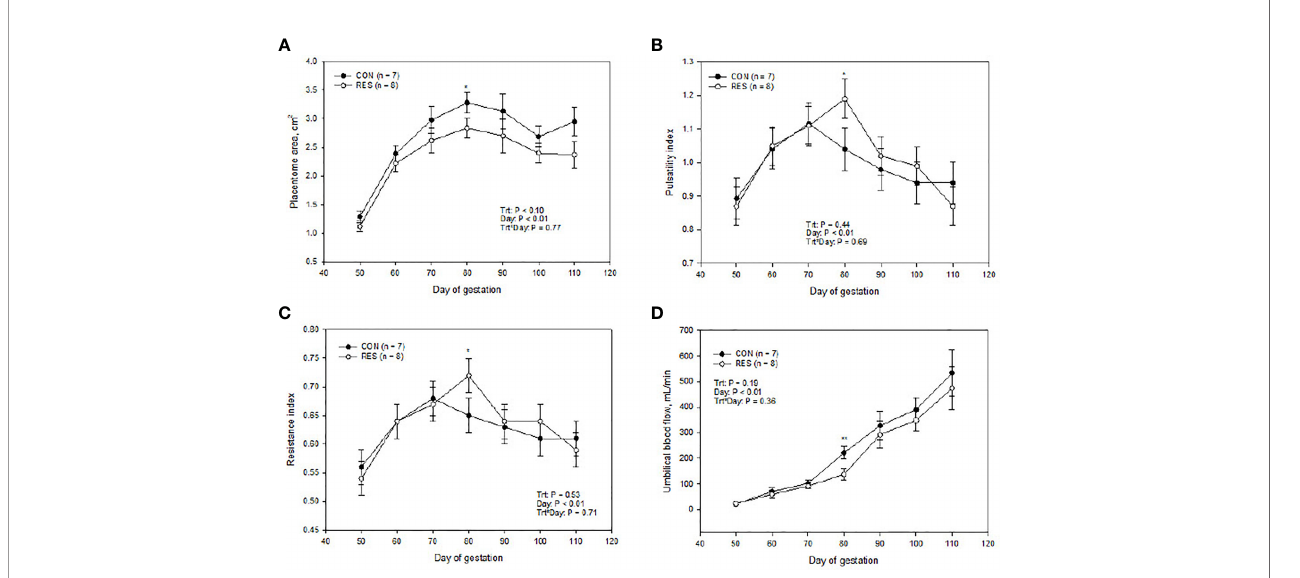
FIGURE 2 | Impacts of maternal nutrition on placentome area (A) , umbilical pulsatility index (B) , umbilical resistance index (C) , and umbilical blood fl ow (D) from d 50 to 110 of gestation. CON = 100% of NRC recommendations. RES = 60% of CON from days 50 to 90 of gestation. Differences between CON and RES are denoted by **P ≤ 0.05, *P ≤ 0.10 within a